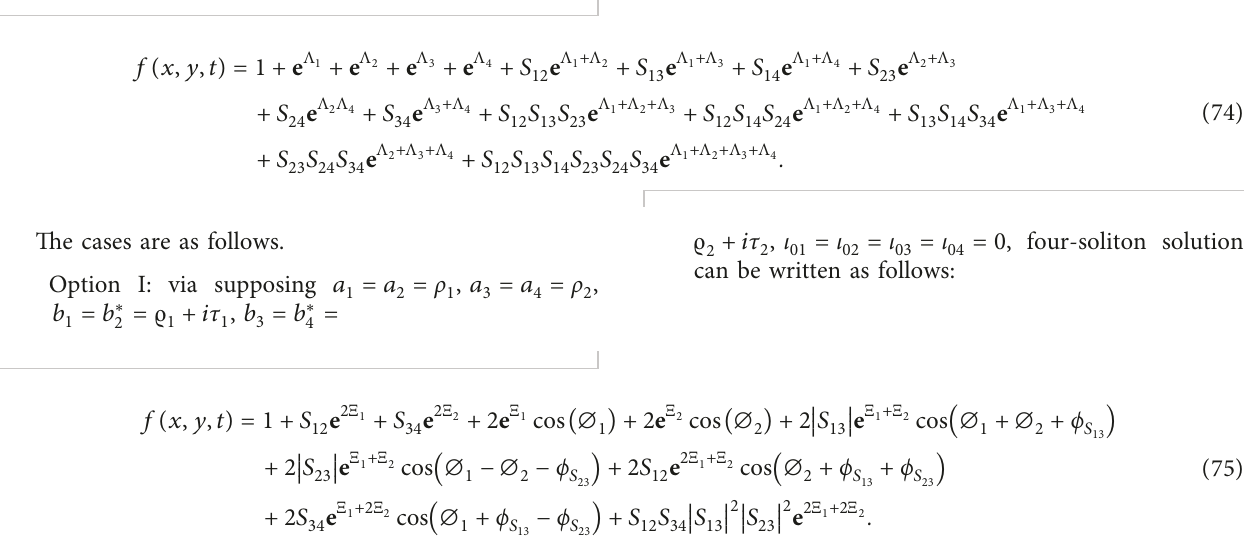
Figure 15: Plots of equation (71) by using c � 1 , c � 1/10. (a) f 1. (b) f 2. (c) f 3. (d) f 4. (e) f c 0 1